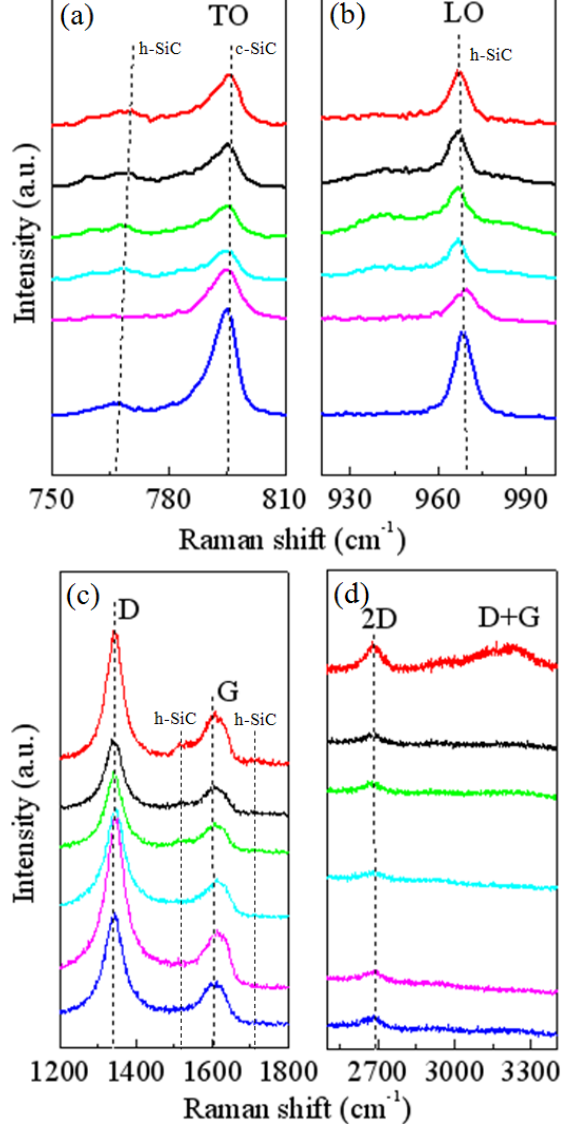
Figure 5. Raman spectra measured at six different points on our sample. (a) TO bands; and (b) LO bands of Raman spectra of SiC films; (c) D bands and G bands of Raman spectra of GGNs, together with second-order SiC bands; (d) 2D bands of Raman spectra of